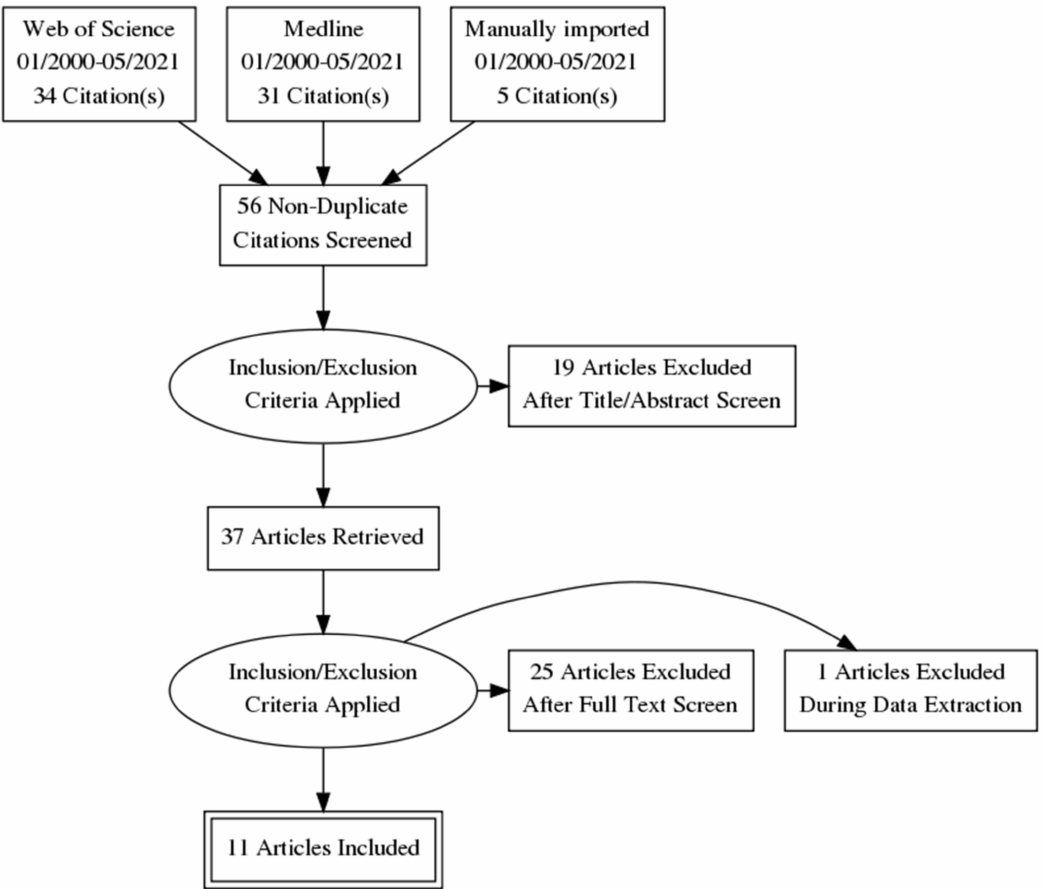
Figure 5. Flow diagram. A total of 65 potentially relevant records were identified searching Web of Science and Medline and further processed. Additional 5 records were identified through other sources. After duplicate removal, 56 records were further examined based on title and abstract. Then, 19 records were removed as they did not cover the eligibility criteria (described in Table S1). A total of 37 articles were identified to be full-text read. Thereafter, 26 articles were excluded due to the reasons described in Table S1. Finally, a total of 11 studies were included in the present